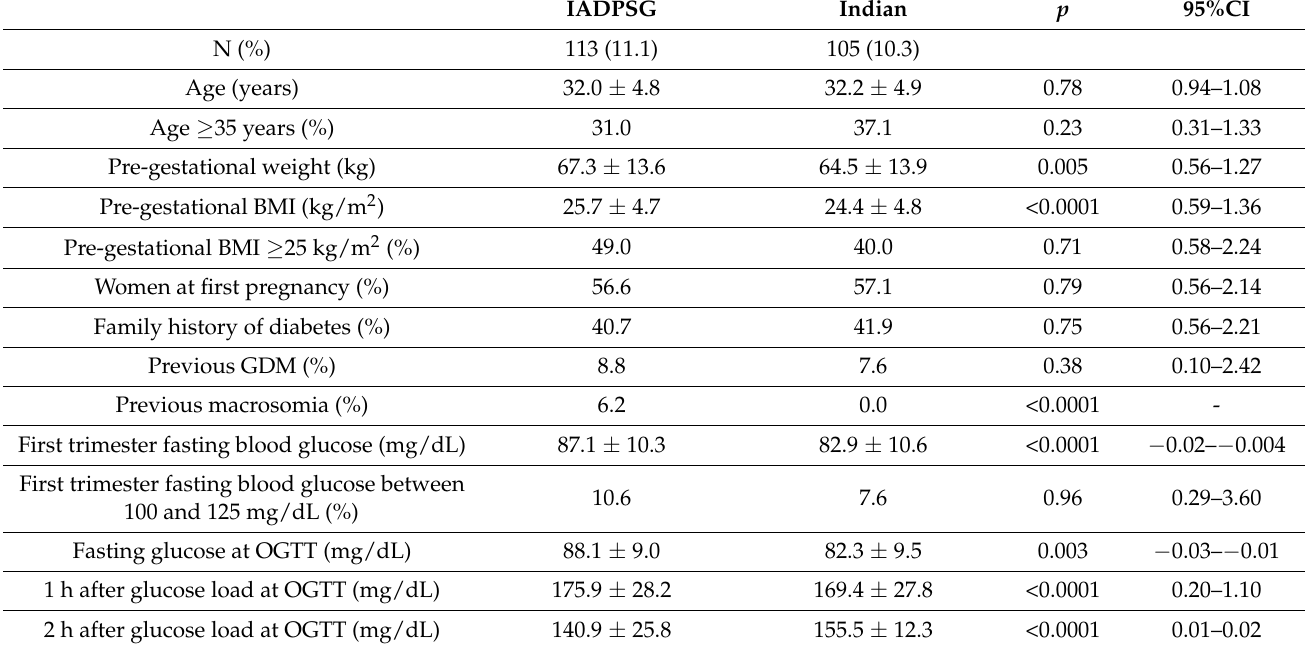
Table 1. Clinical characteristics of women with GDM diagnosed by IADPSG and Indian